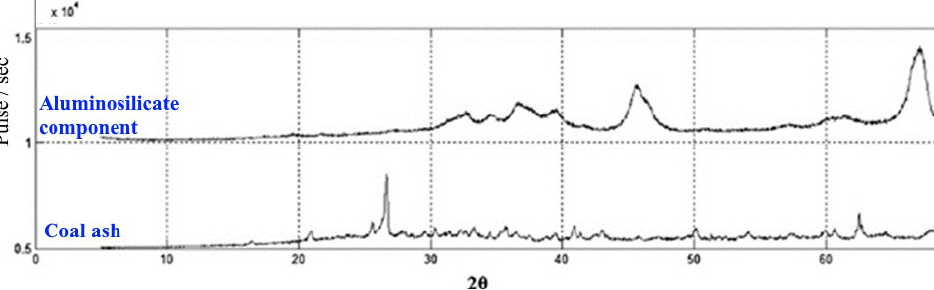
Figure 19. Change in the strength of the developed composites.